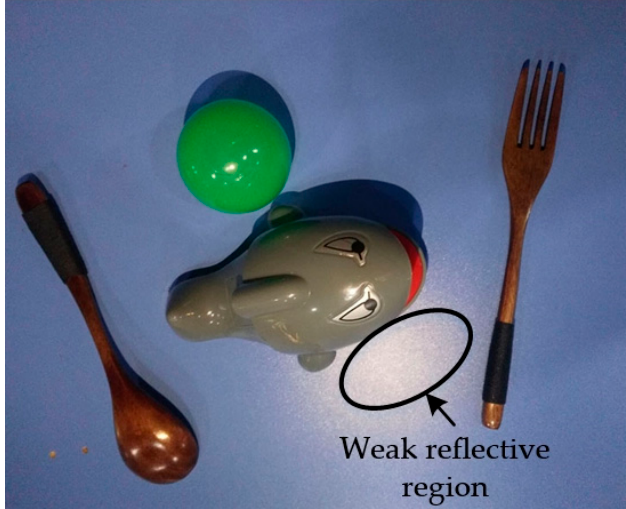
Figure 2. Weak reflective region.